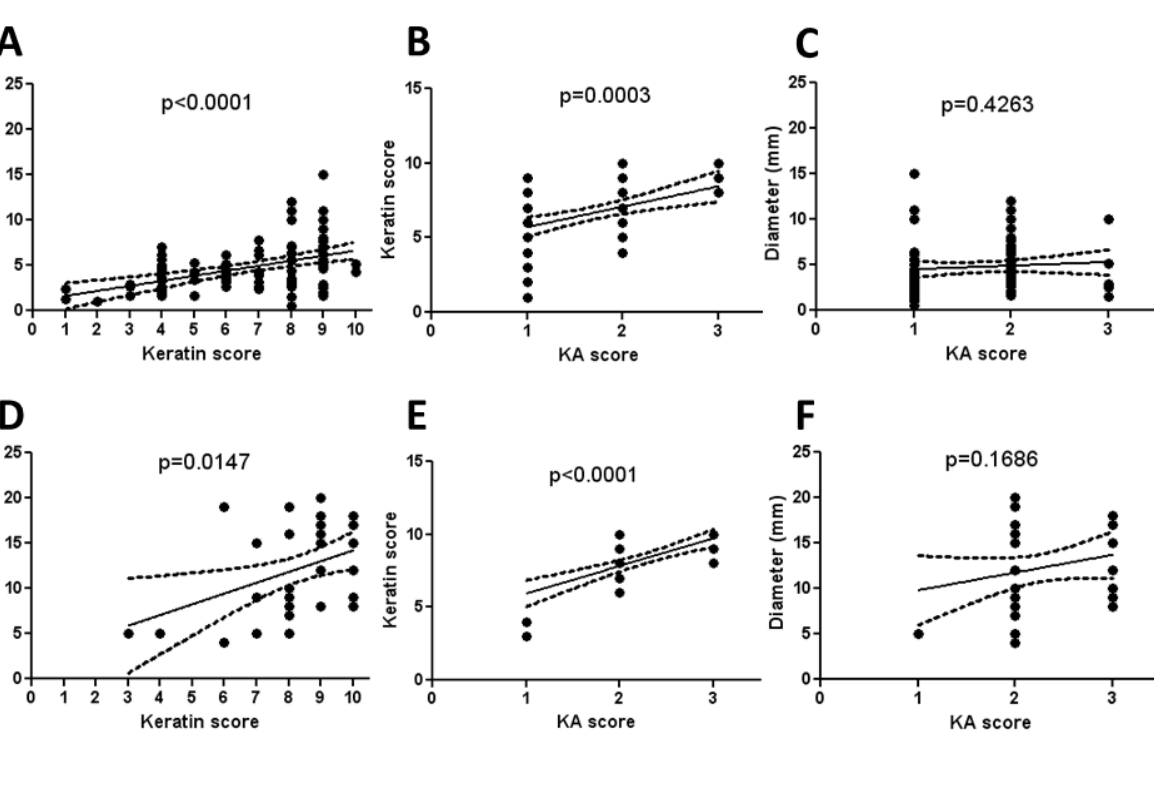
Figure 5. Morphometry and histopathological scoring of KAs. KA diameter was measured